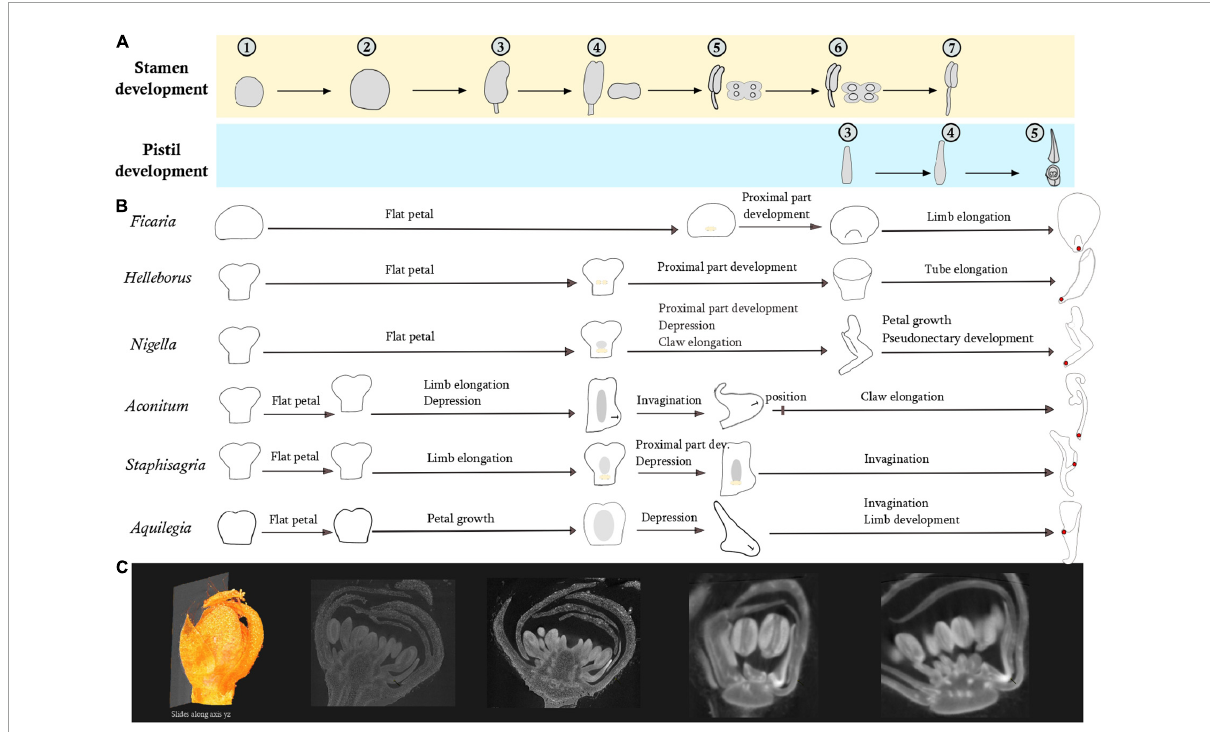
FIGURE4 Comparison of petal development sequences of the six species representative of the morphological diversity using fertile organ development as reference. (A) Pistil and stamen development. Developmental stages of stamens: (1–2) Increase of the primordium size (2–3) filament/anther differentiation (3–4) differentiation of the two thecae (4–5) Connective differentiation (5–6) Stamen form is acquired, formation of the pollen sacs (6–7) Stamen elongation. Developmental stages of pistil: (3–4) Acquisition of the form (4–5) Ovules in the process of formation. (B) In yellow, development of bulges in the adaxial side. In gray, development of a depression in the abaxial side. (C) Example of a virtual section from a 3D floral bud reconstruction of Staphisagria picta